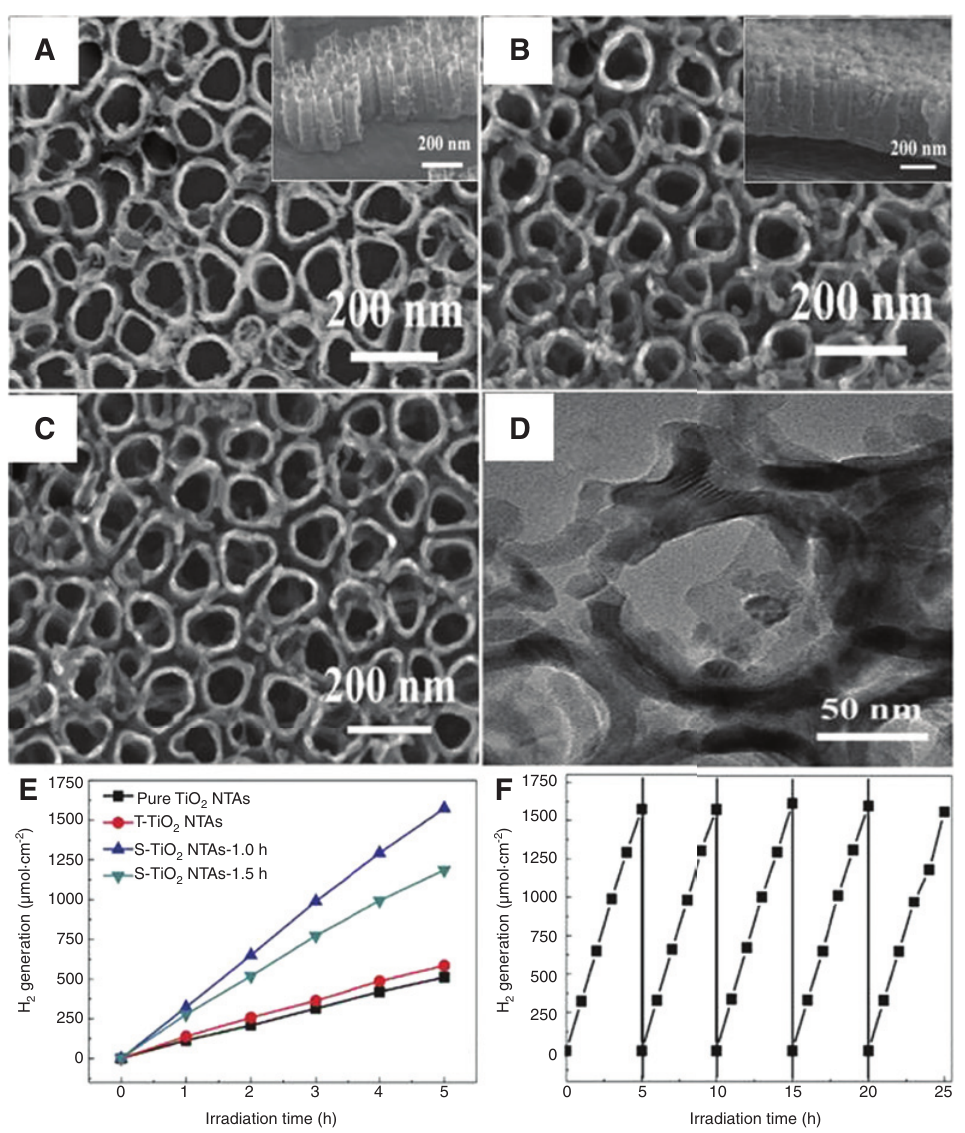
NTAs (A), TiO nanoparticles modified TiO 2 2 /TiO hetero-nanoparticles modified TiO 3 2 NTAs (T-TiO NTAs), SrTiO /TiO NTAs (S-TiO 2 2 3 2 NTAs (F). Reproduced from Ref. [207] with permission. Copyright 2